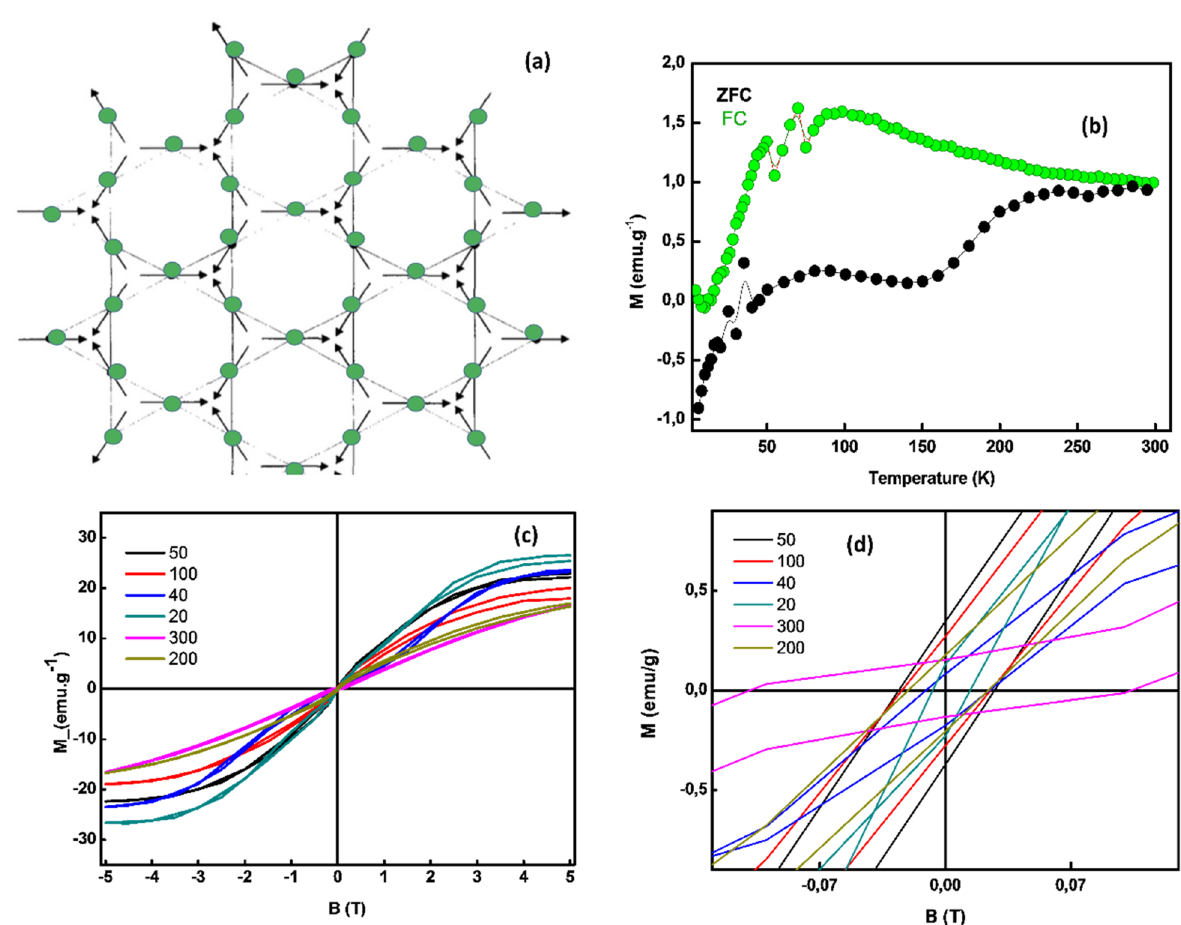
Figure 7. ( a ) Kagome lattice of anti-ferromagnetically coupled Heisenberg spins with the so-called q = 0 structure in Jarosites, ( b ) plot of zero field cool (ZFC) and field cool (FC) of the sample showing a blocking temperature of the sample, ( c ) inverse susceptibility plot versus temperature with the applied field at 1 T. ( d ) Magnetization plot of the sample at various temperatures and ( e ) zoomed in plots of the magnetization of the sample at various